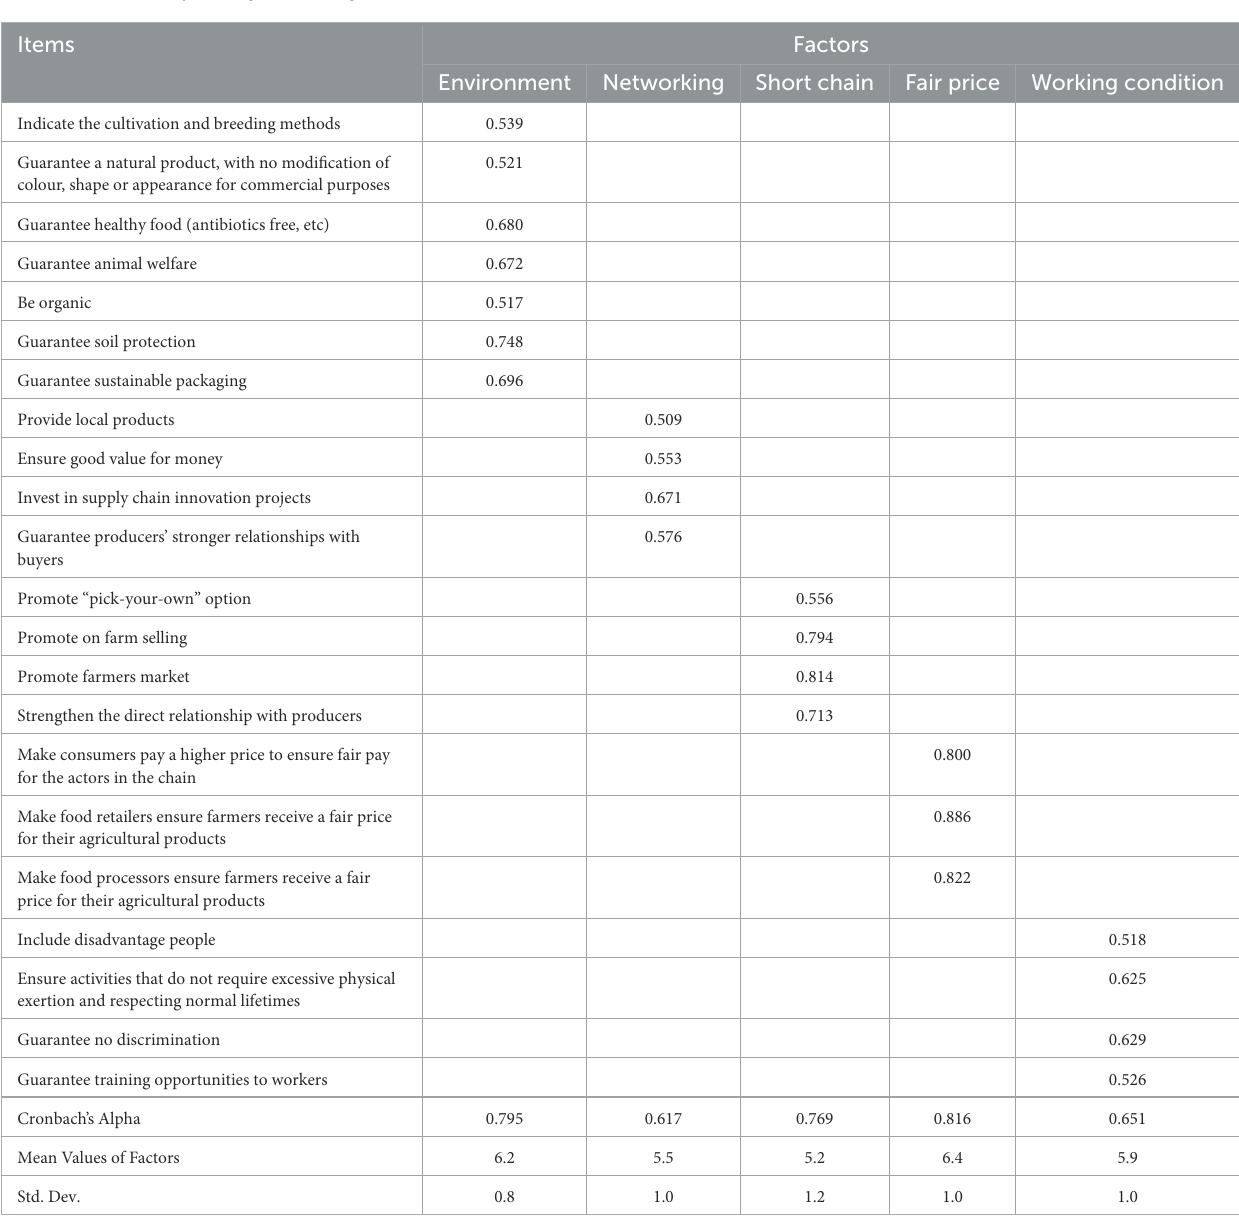
TABLE 4 Results of Exploratory factor